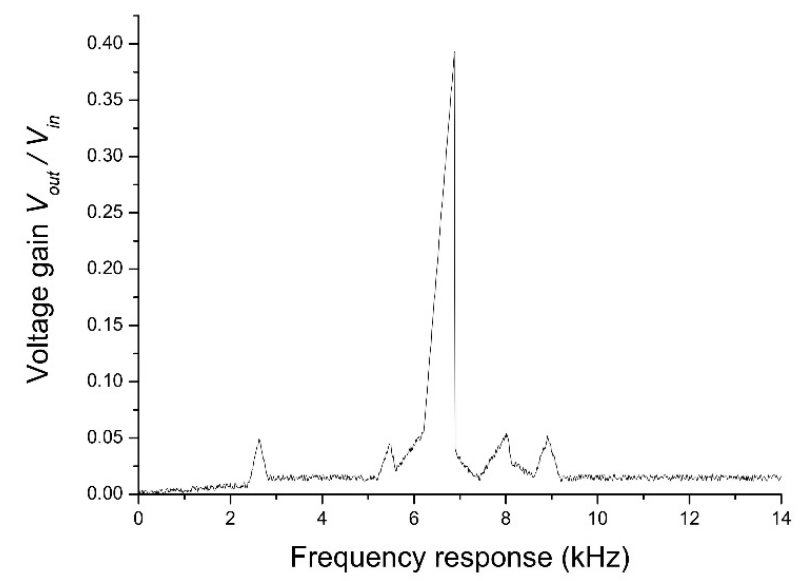
Figure 4. Frequency response was measured by spectrum analyzer.